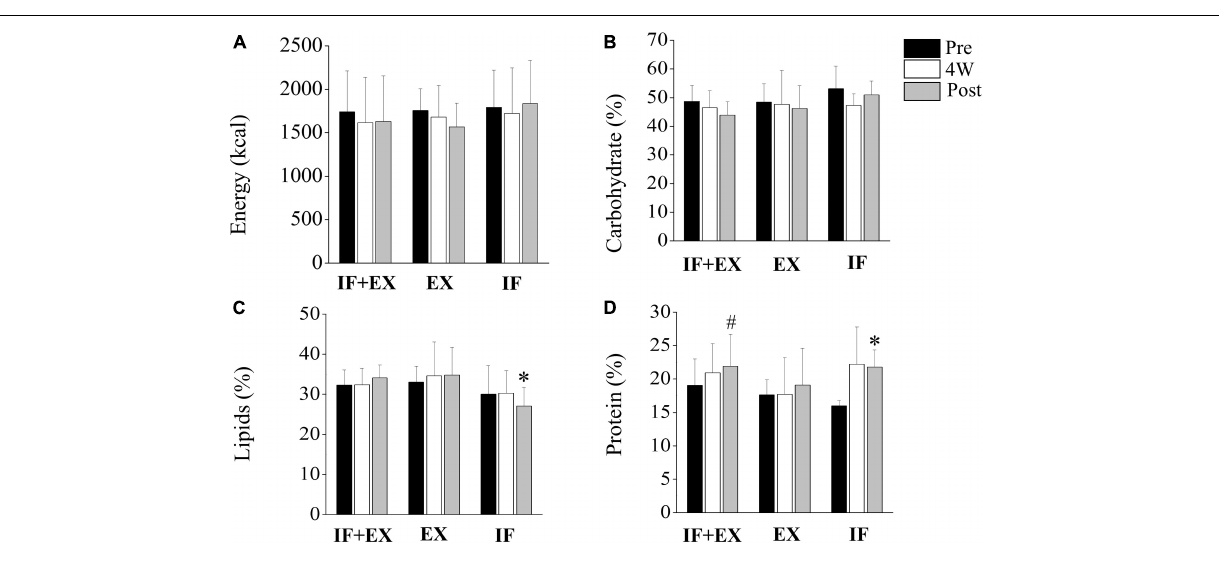
FIGURE 3 | Food consumption pre- and post-intervention. IF + EX, intermittent fasting group in conjunction with exercise ( n = 15); EX, exercise group ( n = 11); IF, intermittent fasting group ( n = 7); 4W, fourth week. Values expressed as mean ± standard deviation. (A,B) : no differences for energy (kcal) and carbohydrate (%) consumption. (C) ∗ Difference between groups post intervention (IF vs IF + EX and EX); (D) *Difference within group post vs pre for IF group; # difference within group post vs pre for IF + EX group, ( p < 0.05), by ANOVA two-way mixed repeated measure, Sidak post hoc , and Welch’s correction for